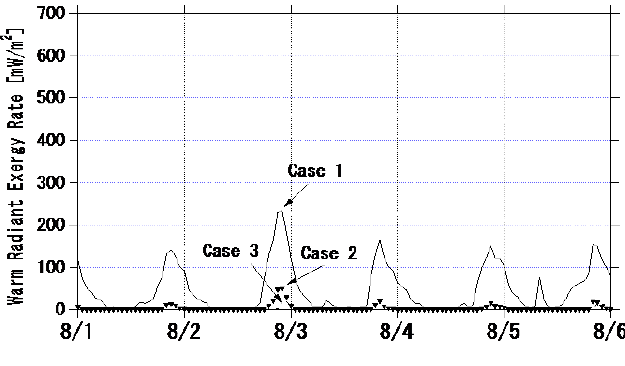
Figure 8. Warm radiant exergy input